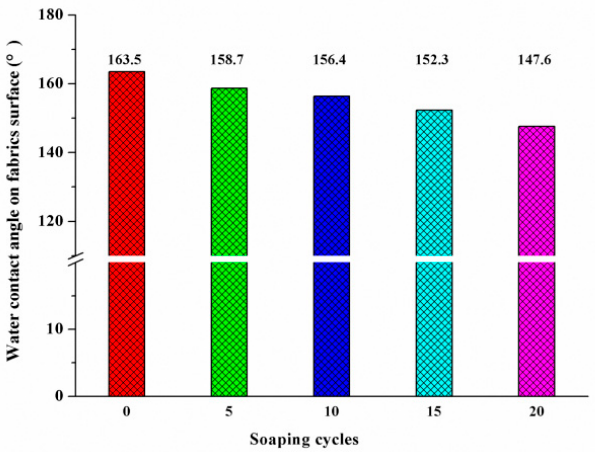
Figure 7. Washing durability of the superhydrophobic fabric.